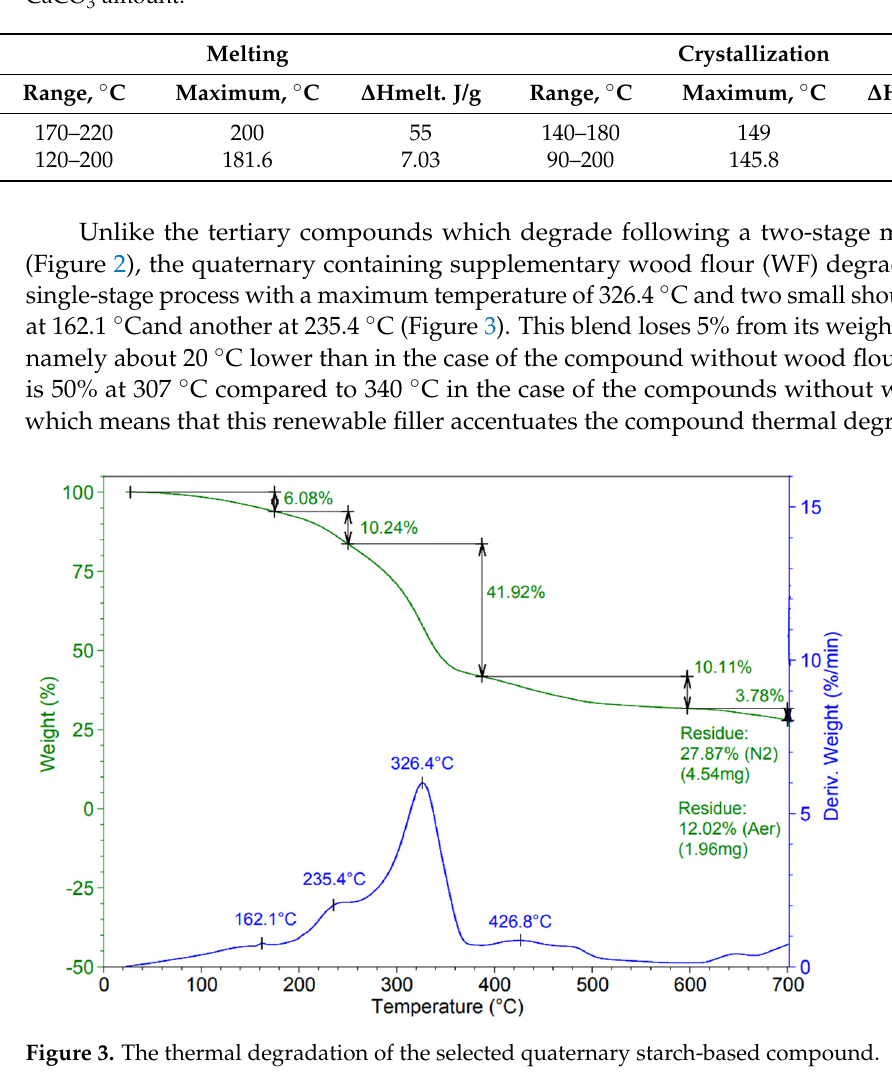
( b ) Figure 2. Degradation behaviour of ternary starch-based blends with different CaCO 3 amount: ( a )- TGA curves; ( b ) DTA curves. The presence of the 33% wood flour in the ternary blend of starch with 33% PVOH and 37% CaCO 3 changes entirely the thermal behaviour: the wood flour decreases the